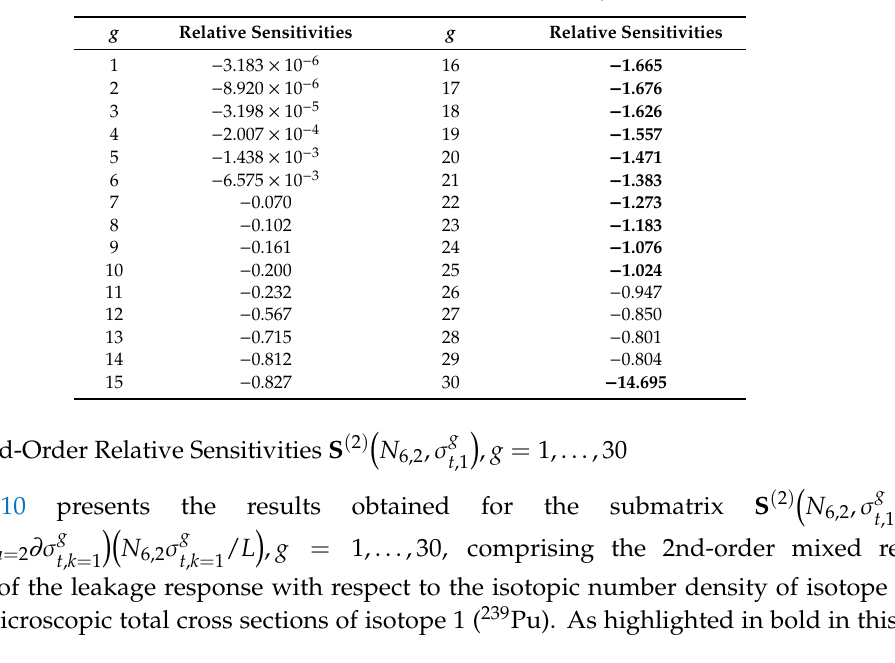
(cid:16) (cid:17) (cid:44) N 5,2 , σ g t ,6 (cid:16) (cid:17) N 5,2 , σ g , g = 1, ... ,30. t ,6